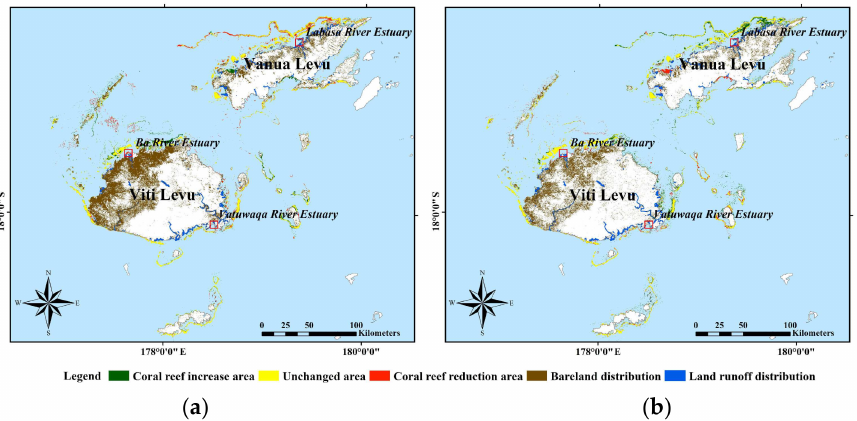
Figure 10. Area changes in coral reefs in Fiji. ( a ) change between 2002 and 2014; ( b ) change between 2014–2019. The distribution of bare land shows data for 2014 and 2019, respectively, in ( a , b ).